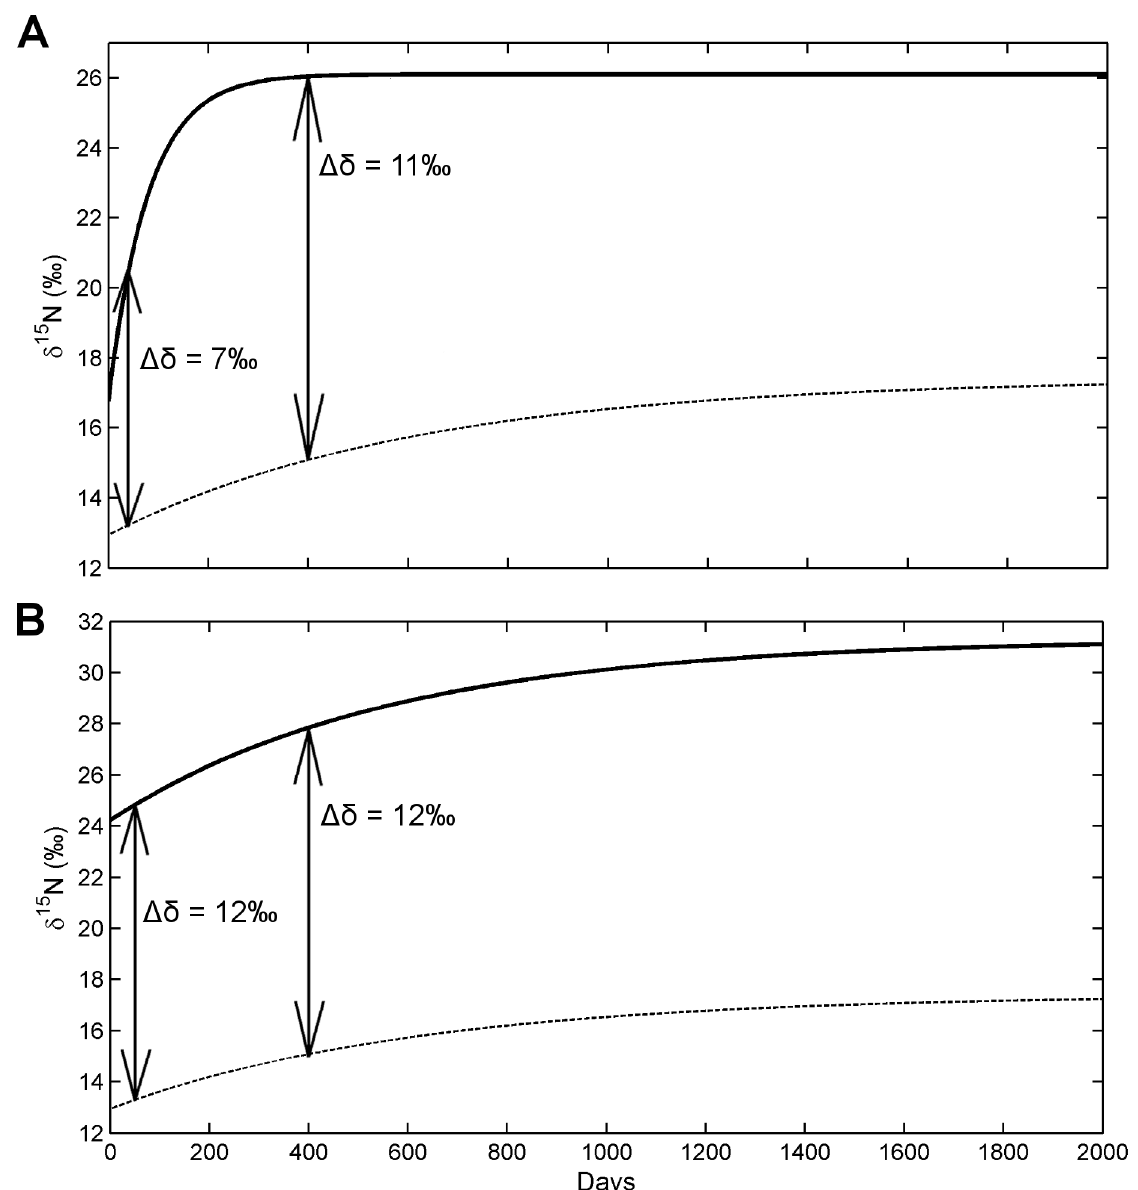
Figure 6. Schematic of fractionation between amino acids following a diet shift with variable incorporation rates. Difference in d 15 N values of two combinations of source and trophic amino acids. A) Isotopic change between source (dashed line) and trophic (solid line) amino acids with dissimilar turnover rates at two time points compared to B) those of source (dashed line) and trophic (solid line) amino acids turning over at similar